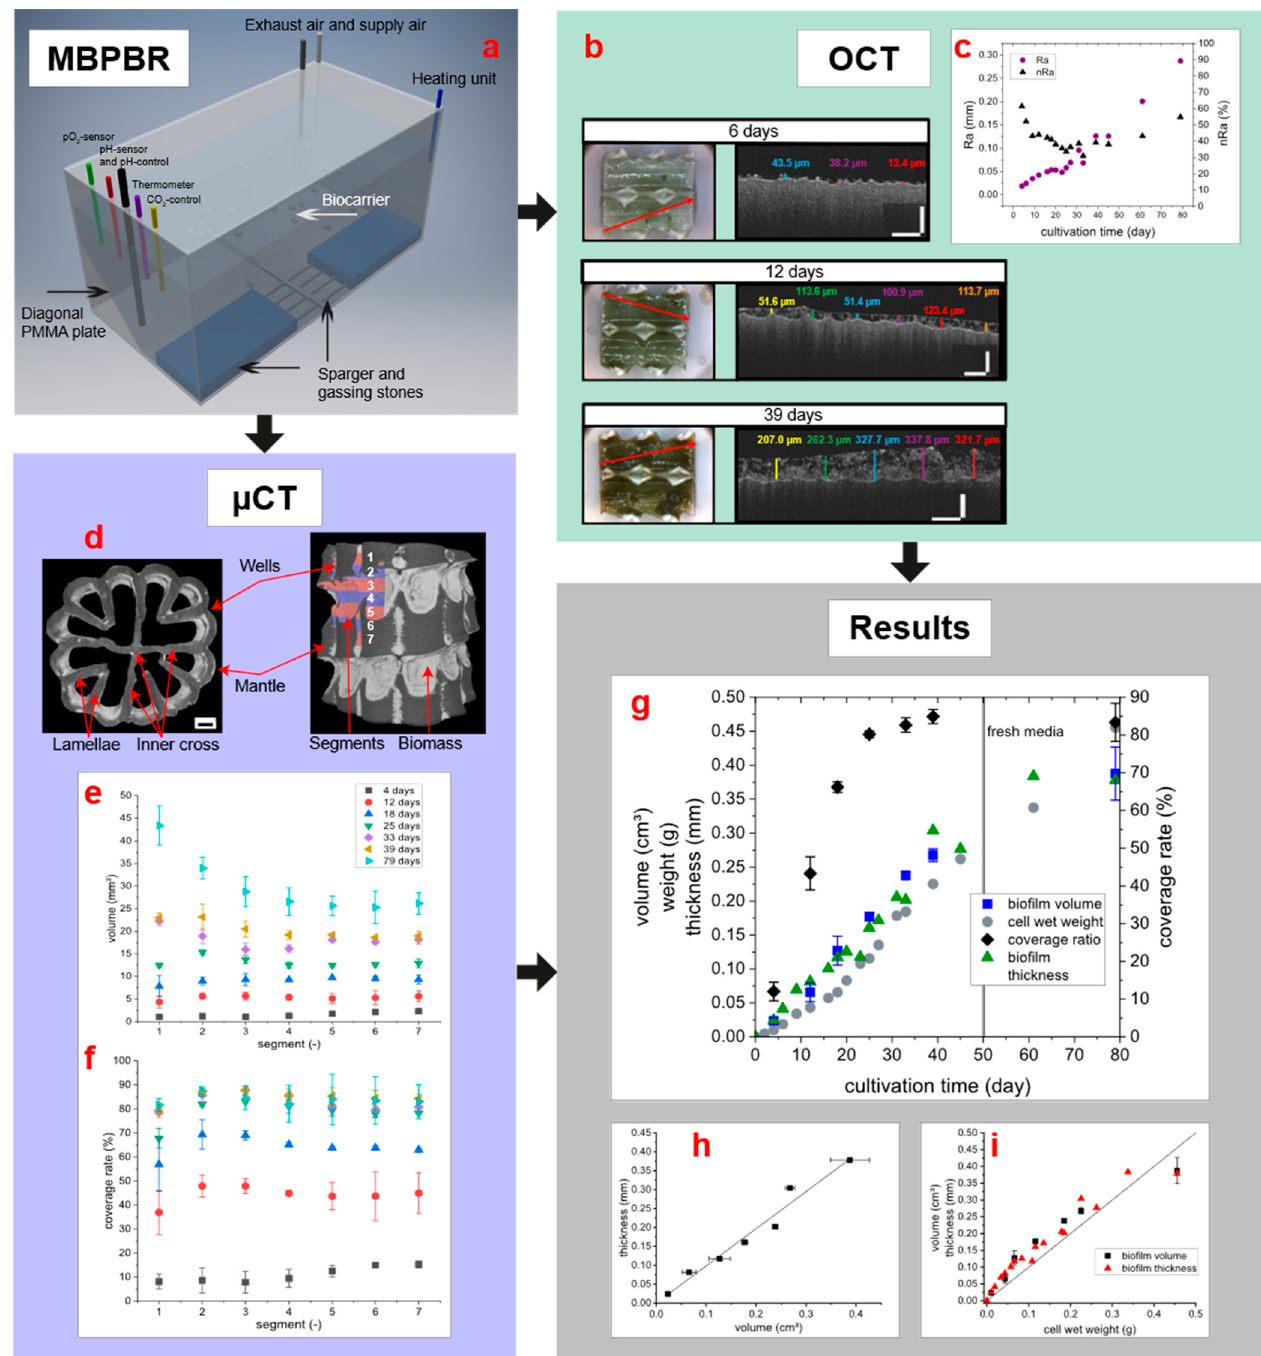
Figure 2. Monitoring the development of the biofilm of T. distorta using μ CT and OCT. ( a ) Illustration of the moving bed photobioreactor (MBPBR) used for phototrophic cultivation of Tolypothrix distorta on the biocarriers. ( b ) Representative optical coherence tomography (OCT) 2-D scans of the carriers at different cultivation times. Left: Photographs of the prepared carriers (cut open), the scan position is indicated in red. Right: Sections of the OCT scans, with the measured thickness of the biofilm plotted. The carrier is located below the biofilm. Scale bar corresponds to 250 µ m. ( c ) Arithmetic roughness and normalized (to respective mean) arithmetic roughness of the biofilm over the cultivation period ( n = 1). ( d )